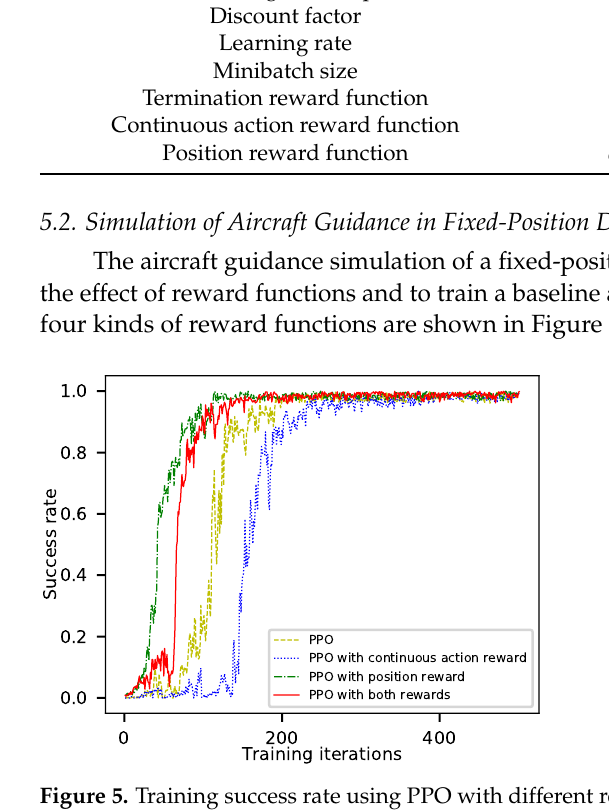
Figure 5. Training success rate using PPO with different reward functions. The system converged after 200 training iterations using PPO only. The training speed of PPO with continuous-action reward function is the slowest, and the system converged after nearly 300 iterations. PPO with position reward function has the fastest training speed, and the system converged after about 100 training iterations. The system converged after 150 iterations using PPO with both reward functions. We found that during training, using different reward functions only makes a difference in training efficiency, and their success rates are stable at high levels after